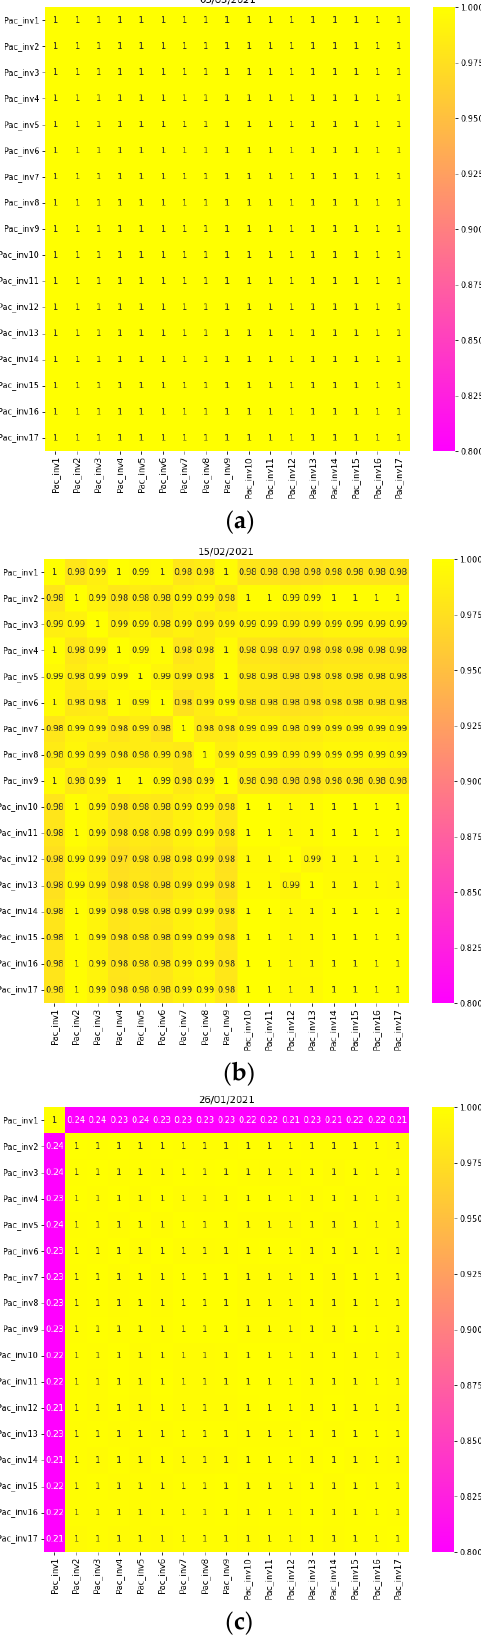
Figure 15. Graphical representation of the matrix of the correlation indexes of the power production at the output of the 17 inverters ( P ac ) of plant 2 for 3 March 2021 ( a ), 15 February 2021 ( b ) and 26 January 2021 ( c ).